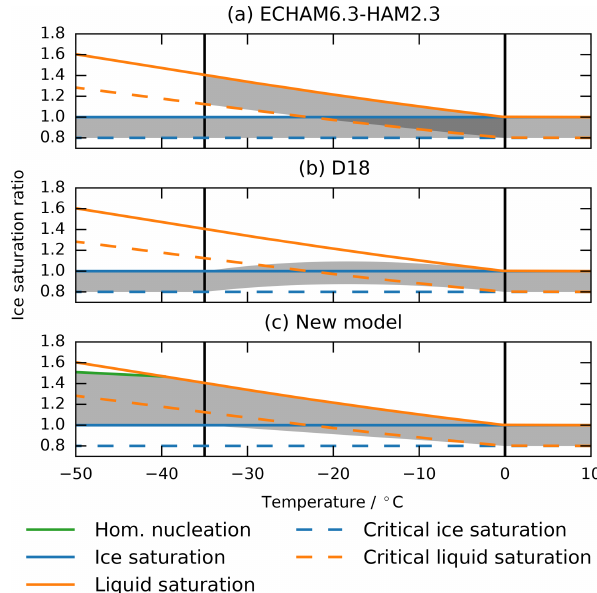
Figure 1. Regions where clouds can form (grey shaded areas) as a function of temperature and supersaturation with respect to ice. The coloured lines show liquid water and ice saturation ratios s w / i (solid lines) and the critical saturation ratios required for first cloud formation (dashed; s w / i K ). We choose a constant K = 0 . 8 for this illustration. Panel (a) shows the sub-grid cloud scheme of the ref- erence model ECHAM6.3-HAM2.3 which switches between liquid and ice saturation in the mixed-phase regime, (b) shows the mixed- saturation approach of Dietlicher et al. (2018) (D18) and (c) shows the new